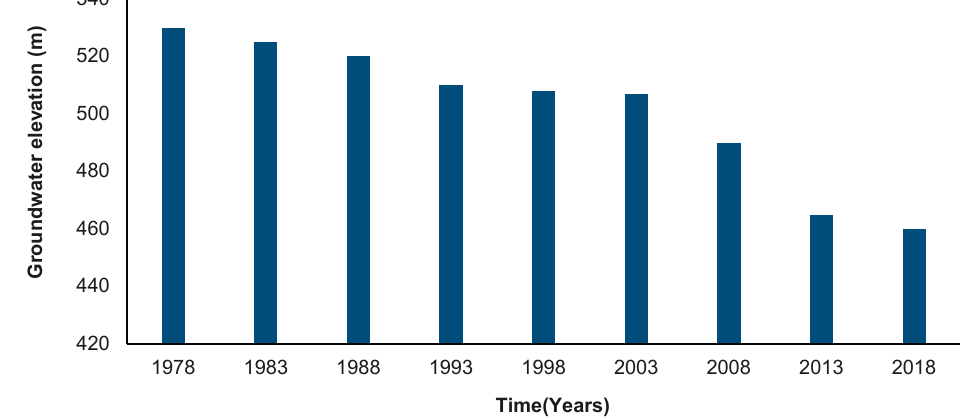
Figure 1. Depletion of groundwater levels of Saq Aquifer in Qassim Region.